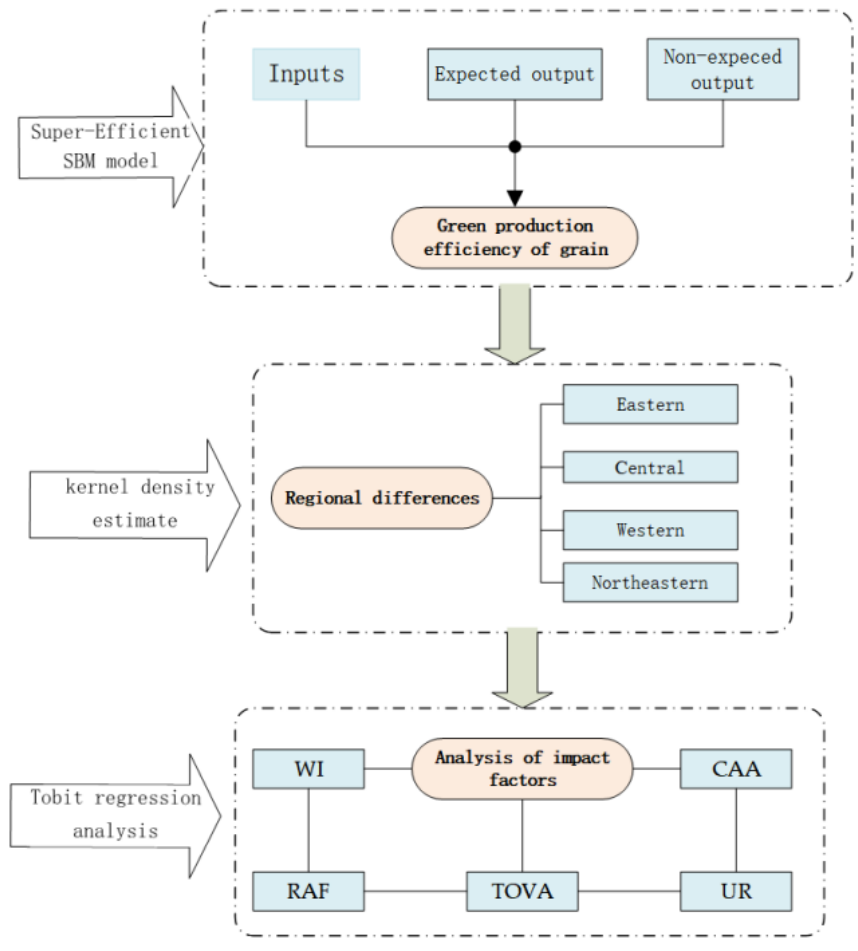
Figure 1. Research technical flowchart.